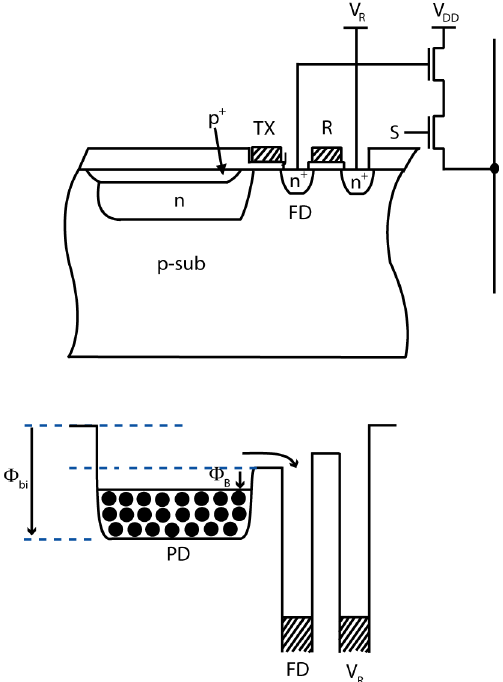
Figure 5. The pixels cross section and potential profile of a photodiode.